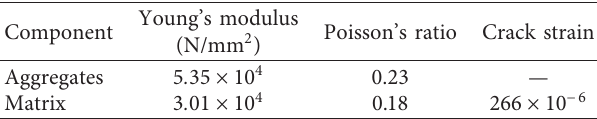
Figure 3: Setup for testing tensile strength of the ITZ. Table 2: Various material parameters used for aggregates and